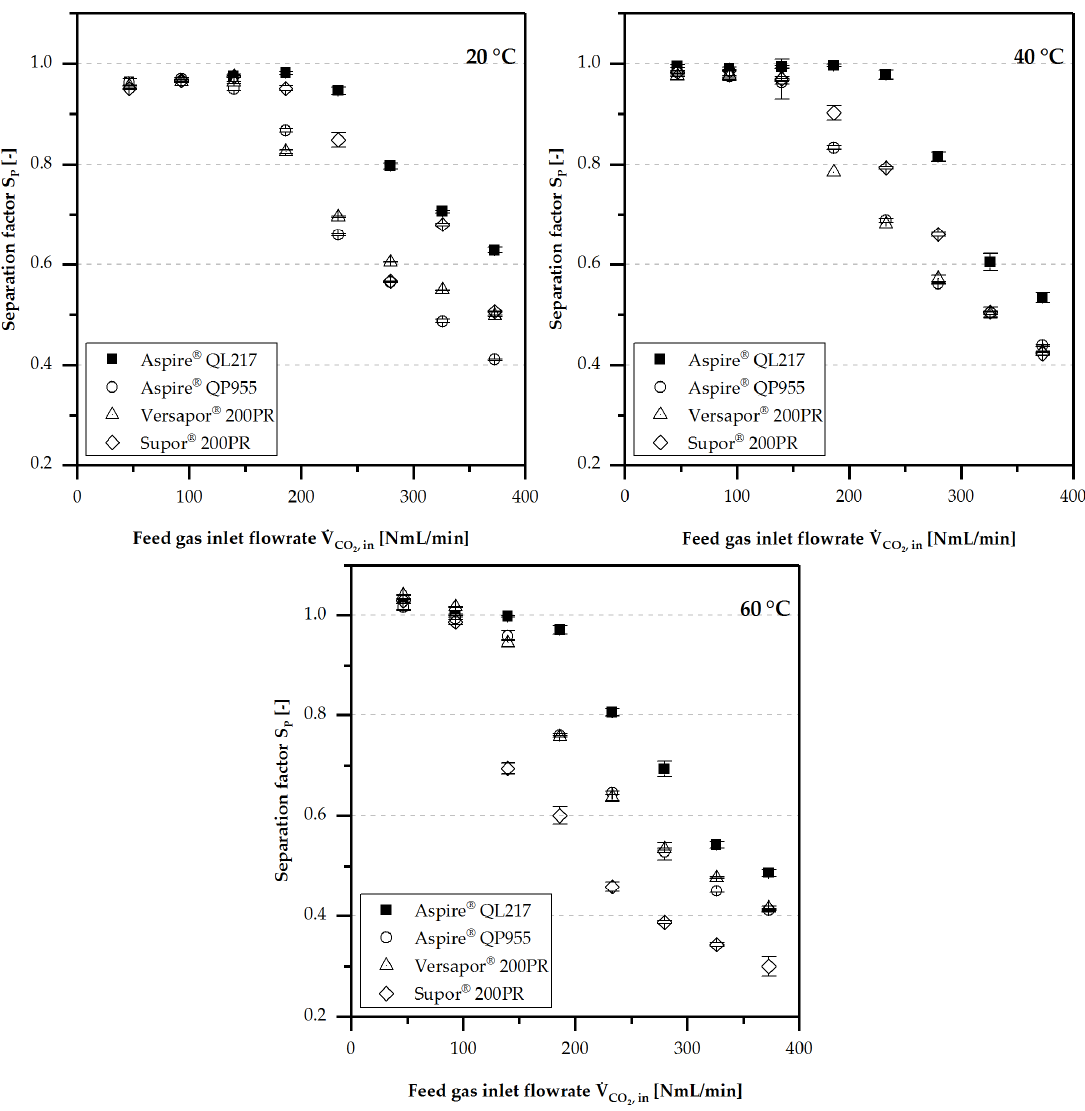
. for different V̇ ,, at ϑ  = 20 °C , for different V g,feed,in at ϑ inlet = 20 ◦ C,  2 = 1 mol/L . = 100 mbar, and c = 1   CH 3 OH TM